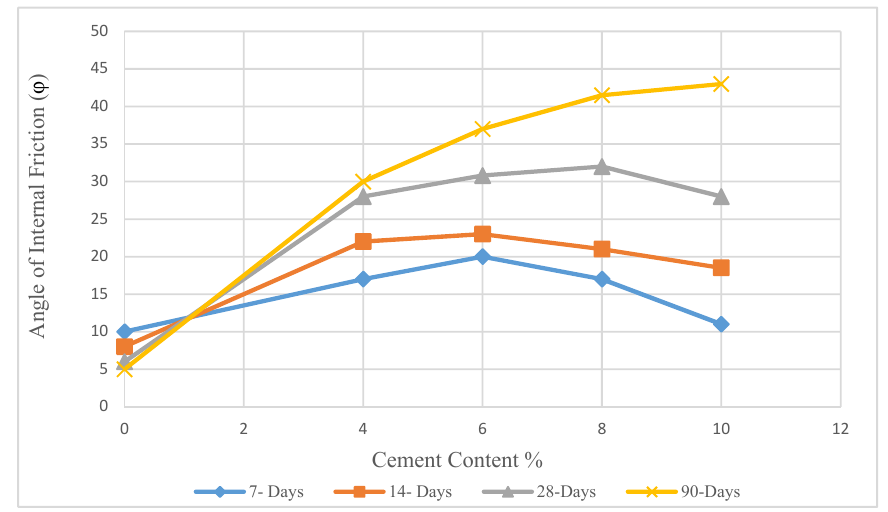
Figure 15. Internal friction angle in treated soil with CRHA 1:2.